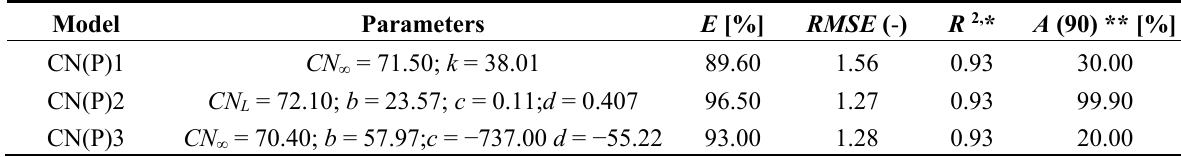
Table 4. P - CN obs parameters of different models and the quality of calculation-observation fit in the watershed B.